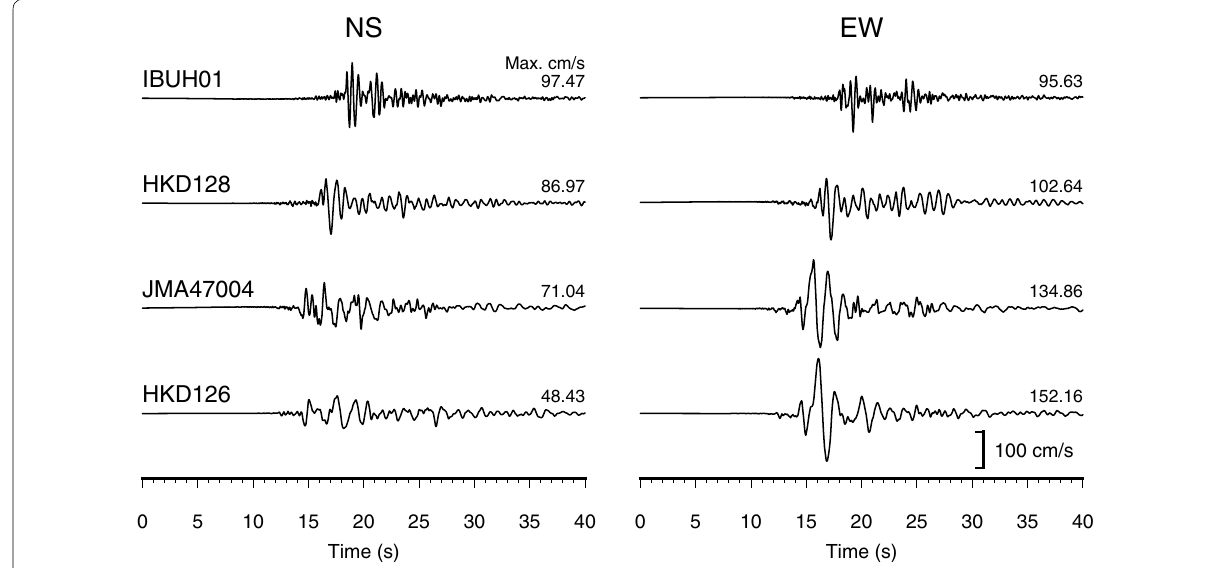
Fig. 2 Ground velocities at four stations. The horizontal velocity waveforms were derived from the acceleration records of selected sites with a 0.05 Hz low-cut filter. The stations correspond to Fig.